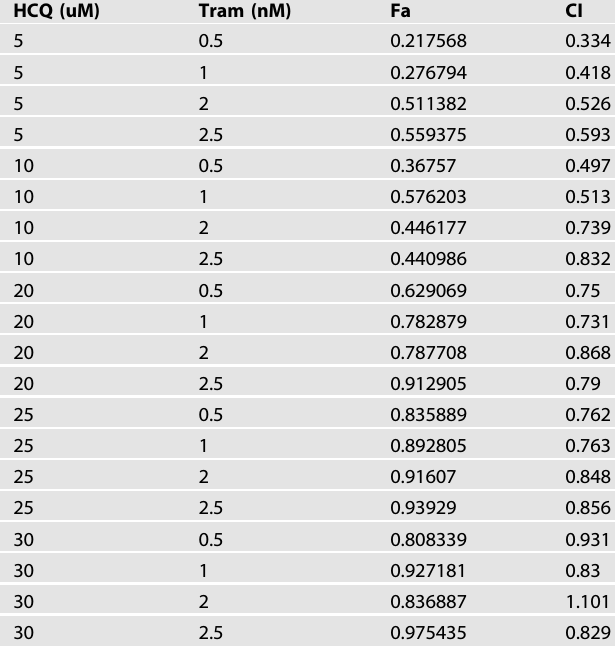
Fig. 1 Inhibition of autophagy by HCQ resulted in KL TDCL, but not KP TDCL, to be sensitive to MEK inhibitor Trametinib. A Clonogenic survival assay of KL (clone 2126 3-2 and clone 2126 5-5) and KP (clone 2871-7 and clone 2871-8) TDCLs treated with HCQ or Trametinib individually at indicated concentrations. B Cell growth inhibition curve of KL (clone 2126 3-2 and clone 2126 5-5) and KP (clone 2871-7 and clone 2871-8) TDCLs treated with HCQ or Trametinib individually at indicated concentrations in Table 1. C Clonogenic survival assay of KL (clone 2126 3-2 and clone 2126 5-5) and KP (clone 2871-7 and clone 2871-8) TDCLs treated with the combination of HCQ and Trametinib at indicated concentrations. D Relative proliferation of KL (clone 2126 3-2 and clone 2126 5-5) and KP (clone 2871-7 and clone 2871-8) TDCLs treated with vehicle control, HCQ (10 μ M), Trametinib (2.5 nM) and the combination. E Western blot for LC3, pERK, total ERK, pS6, total S6 and β -actin of KL and KP TDCLs treated with vehicle control, HCQ (10 μ M), Trametinib (2.5 nM) and the combination for 6 h. F Scheme of the KL or KP TDCLs for measuring oxygen consumption rate (OCR) using Seahorse XFe24 analyzer. G Basal respiration and ATP production of KL TDCLs (clone 2126 3-2 and clone 2126 5-5 (with black squares)) after 6 h ’ treatment with vehicle control, HCQ (10 μ M), Trametinib (2.5 nM) and the combination. H Basal respiration and ATP production of KP TDCLs (clone 2871-1 and clone 2871-8 (with black squares)) after 6 h ’ treatment with vehicle control, HCQ (10 μ M), Trametinib (2.5 nM) and the combination. I Scheme of the metabolomics analysis via LC-MS of KL TDCLs after 6 h ’ treatment. J The levels of metabolites of KL (clone 2126 3-2 and clone 2126 5-5) TDCLs after 6 h ’ treatment with vehicle control, HCQ (10 μ M), Trametinib (2.5 nM) and the combination. K Left: Overlapping images of KL (clone 2126 3-2 and clone 2126 5-5) TDCLs treated with vehicle control, HCQ (10 μ M), Trametinib (2.5 nM) and the combination for 6 h and stained with MitoTracker Red CMXRos for mitochondrial membrane potential and MitoTracker Green FM for mitochondrial mass. Blue: Hoechst 33342 for nuclear staining. Right: graph of the relative mitochondrial membrane potential of KL TDCLs quanti fi ed by the ratio of red fl uorescence intensity and green fl uorescence intensity. L Left: Overlapping images of KP TDCLs (clone 2871-7 and clone 2871-8) treated with vehicle control, HCQ (10 μ M), Trametinib (2.5 nM) and the combination for 6 h and stained with MitoTracker Red CMXRos for mitochondrial membrane potential and MitoTracker Green FM for mitochondria mass. Blue: Hoechst 33342 for nuclear staining. Right: graph of relative mitochondrial membrane potential of KP TDCLs quanti fi ed by the ratio of red fl uorescence intensity and green fl uorescence intensity. M Left: Overlapping images of KL (clone 2126 3-2 and clone 2126 5-5) TDCLs treated with vehicle control, HCQ (10 μ M), Trametinib (2.5 nM) and the combination for 6 h and stained with TMRM (red fl uorescence) for mitochondrial membrane potential. Blue: Hoechst 33342 for nuclear staining. Right: graph of the relative mitochondrial membrane potential of KLTDCLs quanti fi ed by the ratio of red fl uorescence intensity and total cell numbers. N Left: Overlapping images of KP (clone 2871-1 and clone 2871-8) TDCLs treated with vehicle control, HCQ (10 μ M), Trametinib (2.5 nM) and the combination for 6 h and stained with TMRM (red fl uorescence) for mitochondrial membrane potential. Blue: Hoechst 33342 for nuclear staining. Right: graph of the relative mitochondrial membrane potential of KP TDCLs quanti fi ed by the ratio of red fl uorescence intensity and total cell numbers. Data are mean ± s.e.m. * p < 0.05, ** p < 0.01, *** p < 0.001, **** p < 0.0001.